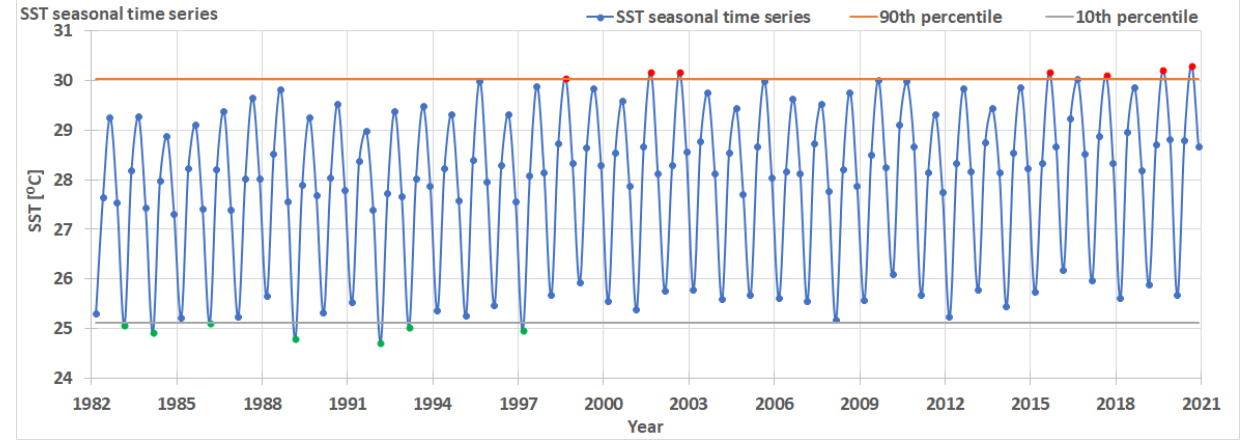
Figure 2. Time series of seasonally mean sea surface temperature over Red+. Warm ETEs (90th percentile) and cold ETEs (10th percentile) are presented in red and green, respectively.